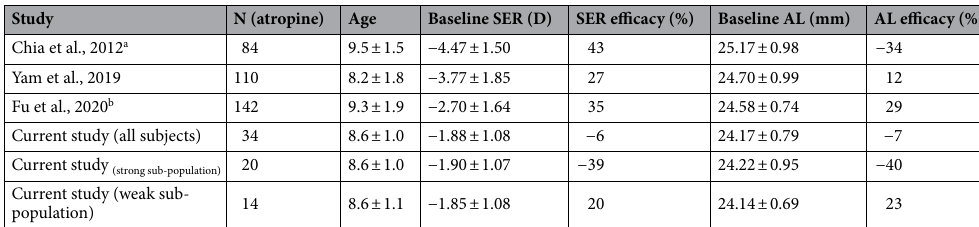
Table 4. Previous prospective, randomized, cohort studies evaluating efficacy of 0.01% atropine in myopia control (Mean ± Standard deviation). Efficacy = ( Treatment − Control )/ Control . a Historical placebo control, b no placebo control. Strong sub-population includes subjects with Ring 1 IC over 41.3 nV/deg 2 for SER and 42.0 nV/deg 2 for AL. Weak sub-population includes subjects with Ring 1 IC below 41.3 nV/deg 2 for SER and 42.0 nV/deg 2 for